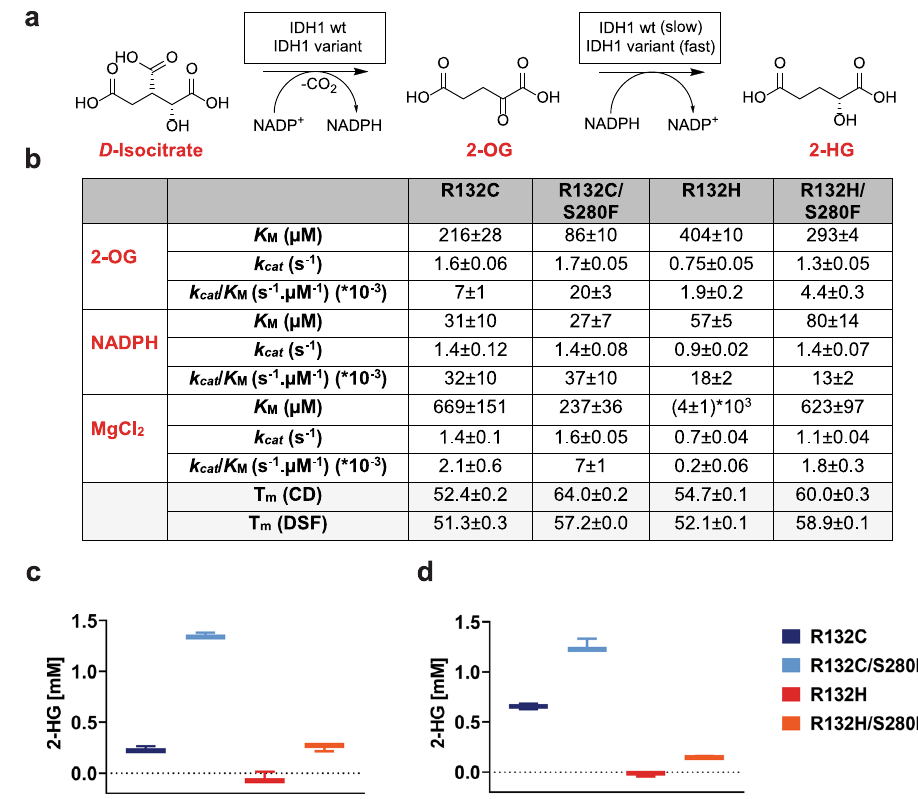
Fig. 1 | The IDH1 S280F substitution increases the ef fi ciency of active site var- iants. a IDH1 variant catalysed oxidation of isocitrate and reduction of 2-OG to 2-HG. b Kinetic parameters for IDH1 variants (400nM) from non-linear regression curve fi ts (standard error of the mean, n =3). Conditions: 100mM Tris, 10mM MgCl 2 , 0.2mM DTT, 0.005% v/v Tween 20, and 0.1mg/mL BSA (pH 8.0). Shaded: Melting temperatures (T m s) of IDH1 variants measured by differential scanning fl uorimetry (DSF, 3 µ M enzyme) or circular dichroism (CD, 0.2mg/mL enzyme); λ :215nm.Conditions:DSF(20mM Tris,100mM NaCl, pH7.4);CD (10mM sodium phosphate, pH 8.0). See Supplementary Information for details. c 2-HG